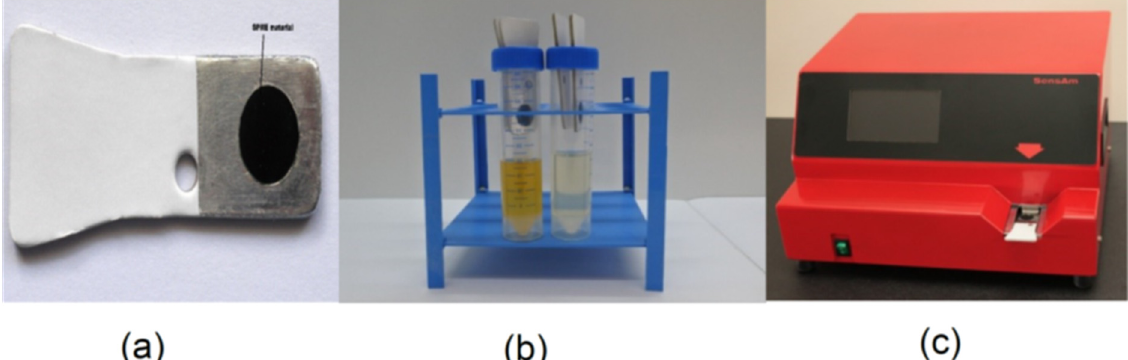
Figure 2. ( a ) Polymer tab used for solid phase microextraction. ( b ) Sampling urine headspace using these tabs ( c ) SensAm analyser. Images are published with the permission of SensAm Ltd., U.K.